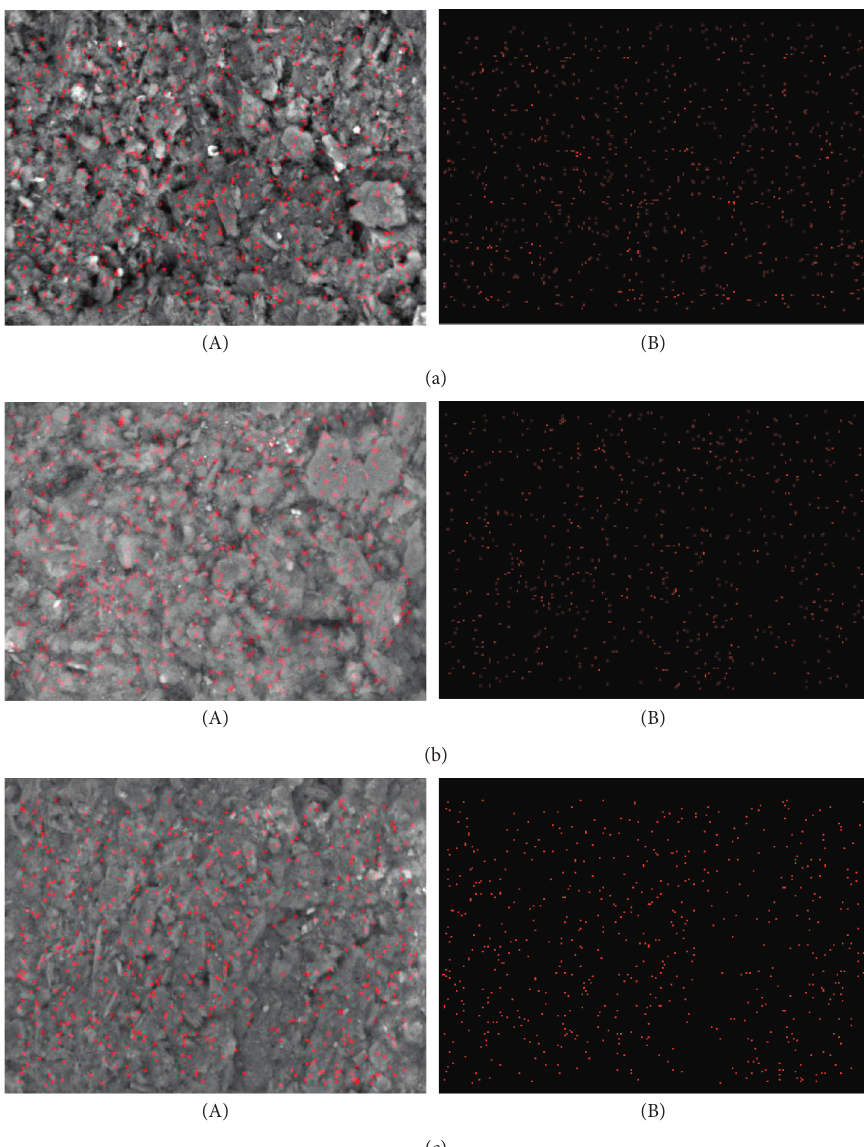
Figure 4: Distribution of AgNPs monitored at the sampling points of (a) SP1 at 10cm, (b) SP2 at 300cm, and (c) SP3 at 600cm from the point of entry of the AgNP solution released to the water body with (i) the FESEM image and (ii) the EDX mapping analysis.